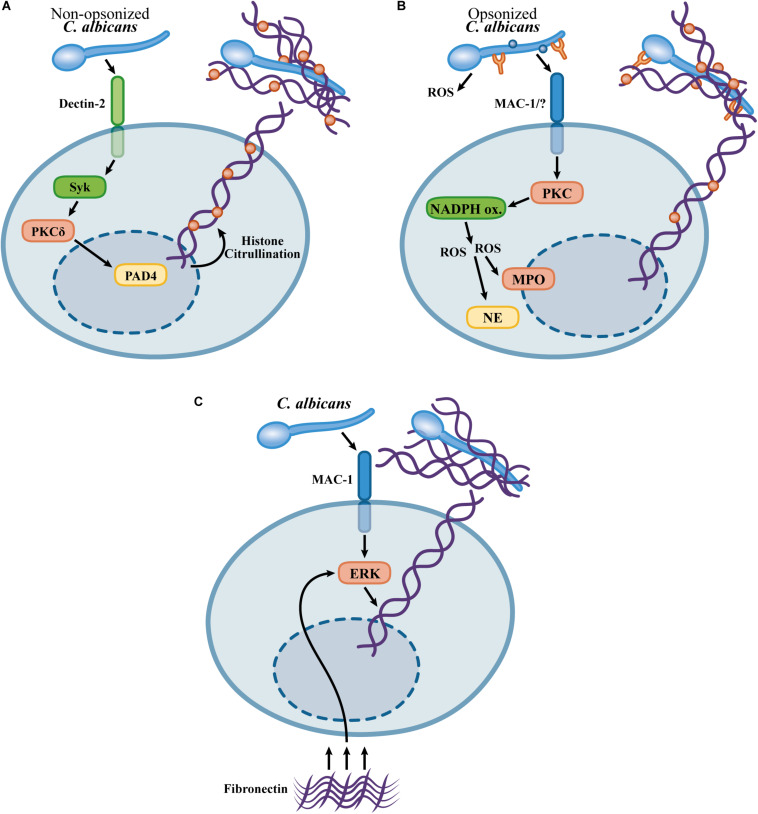
Mechanisms proposed for NET formation in response to Candida albicans. (A) Dectin-2 mediates NETosis in response to non-opsonized C. albicans via a pathway involving Syk, PKCδ, and the PAD4-mediated histone citrullination (Wu et al., 2019). (B) Opsonized C. albicans triggers NETosis by a ROS-dependent pathway involving NADPH oxidase activity (mouse neutrophils) (Ermert et al., 2009) or ROS generation by C. albicans (human neutrophils) (Kenny et al., 2017). PAD4-mediated citrullination is not required for NETosis in response to opsonized C. albicans, however, histone citrullination occurs during NETosis (Kenny et al., 2017; Guiducci et al., 2018). (C) Fast NETosis induced by the crosstalk upon the adhesion to fibronectin and recognition of C. albicans β-glucans by Mac-1 (Byrd et al., 2013).